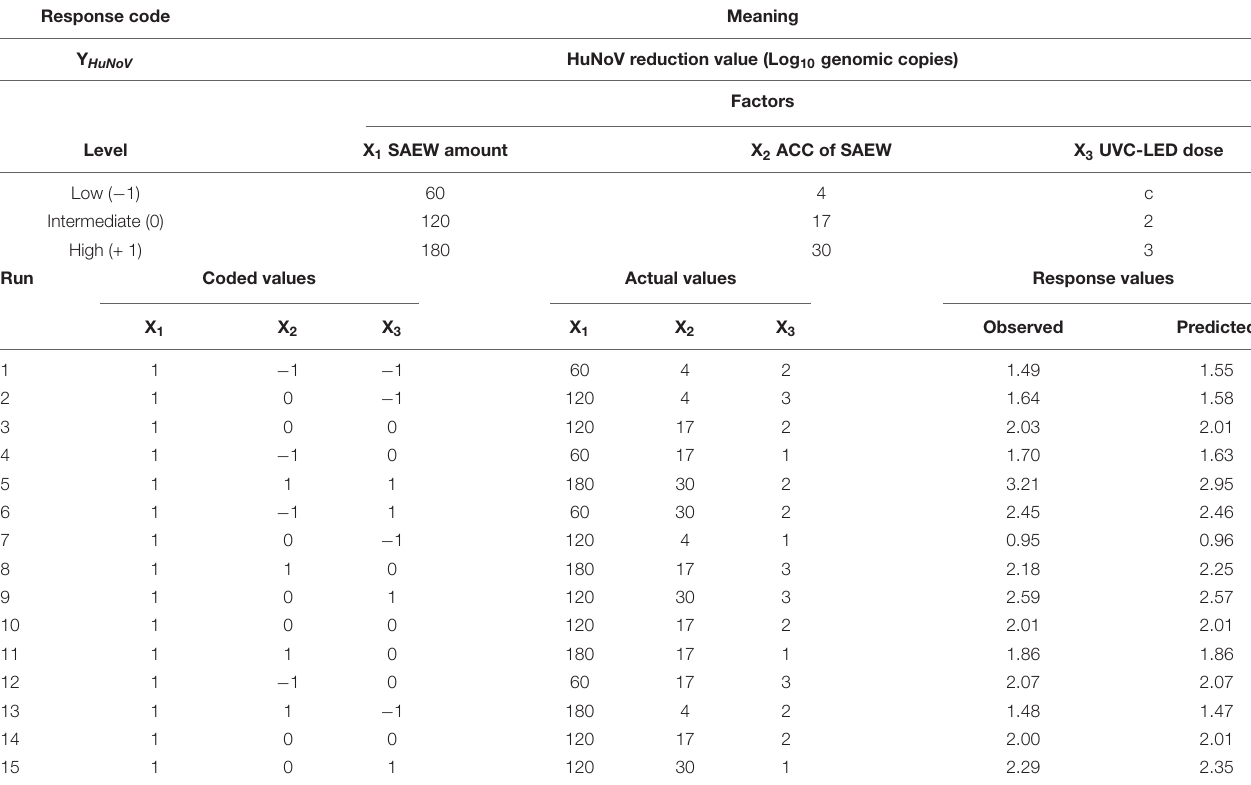
TABLE 1 | Parameters and levels used in the Box–Behnken desig (BBD) matrix for the inactivation of the human norovirus (HuNoV). Response code